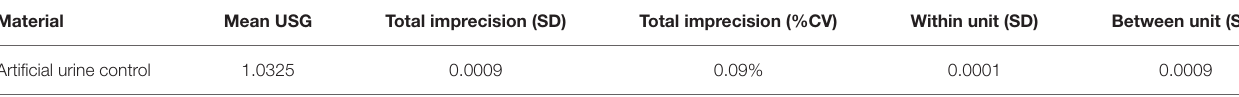
TABLE 1 | Imprecision of InFlow system measured in USG units using artificial urine control.